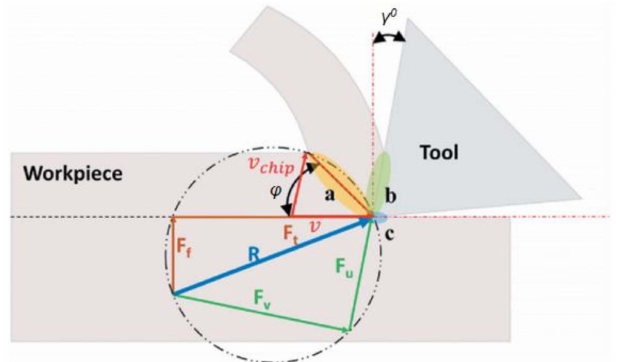
Figure 7. Regions of heat generation during metal orthogonal machining (adapted from [73]): (Caption: ϕ —shear plane angle; γ 0 —Rake angle, F f —Feed force, F t —tangential